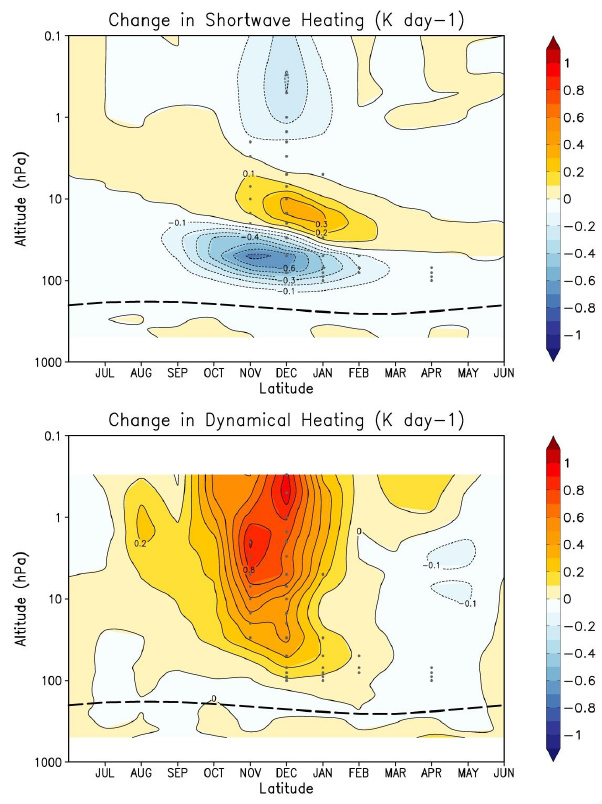
Figure 7: Zonal mean, monthly mean shortwave heating (top) and dynamical heating Figure 7. Zonal mean, monthly mean short-wave heating (top) (bottom) differences between REF2000 and NHC, averaged over 90°-75°S. Contour and dynamical heating (bottom) differences between REF2000 and NHC, averaged over 90–75 ◦ S. Contour intervals are 0.1Kday − 1 . intervals are 0.1 K day -1 . Stippling denotes significance at the 95% confidence level. The Stippling denotes significance at the 95% confidence level. The bold dashed line signifies the tropopause height in the REF2000 simulation. bold dashed line signifies the tropopause height in the REF2000